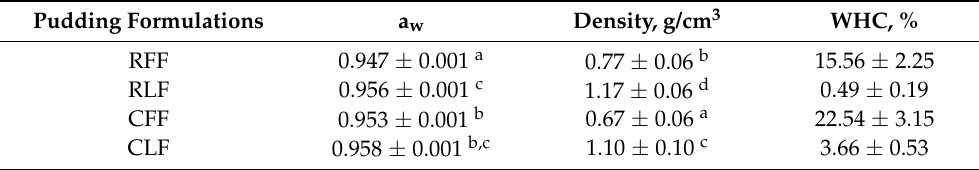
Table 5. Water activity (a w ), water holding capacity (WHC) and density of pudding formulations (RFF—rice starch, peach pur é e; RLF—rice starch, lyophilized fruit; CFF—corn starch, peach pur é e; CLF—corn starch, lyophilized